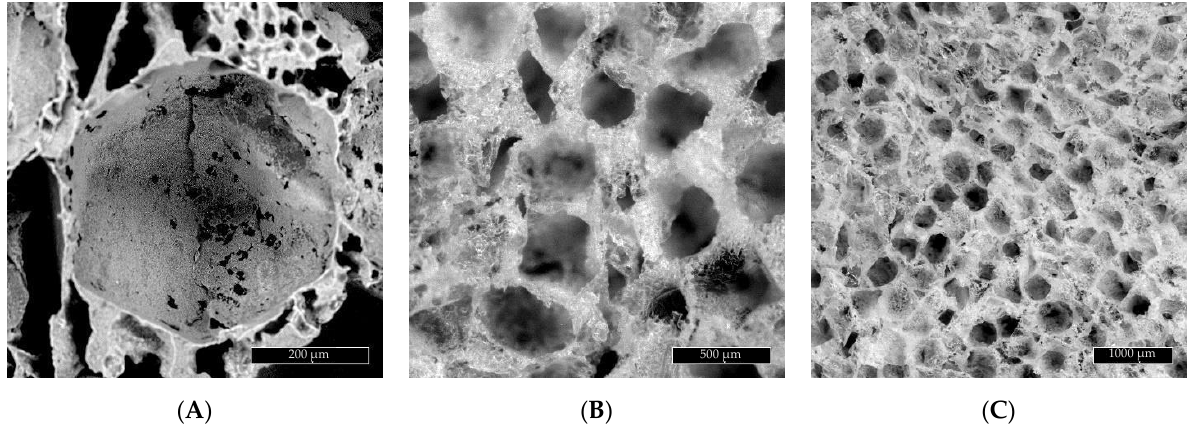
Figure 2. ( A ) SEM images of the PGS/HAp scaffold pores. ( B ) Optical image of the PGS/HAp scaffold. ( C ) Optical image of the PGS/HAp scaffold.